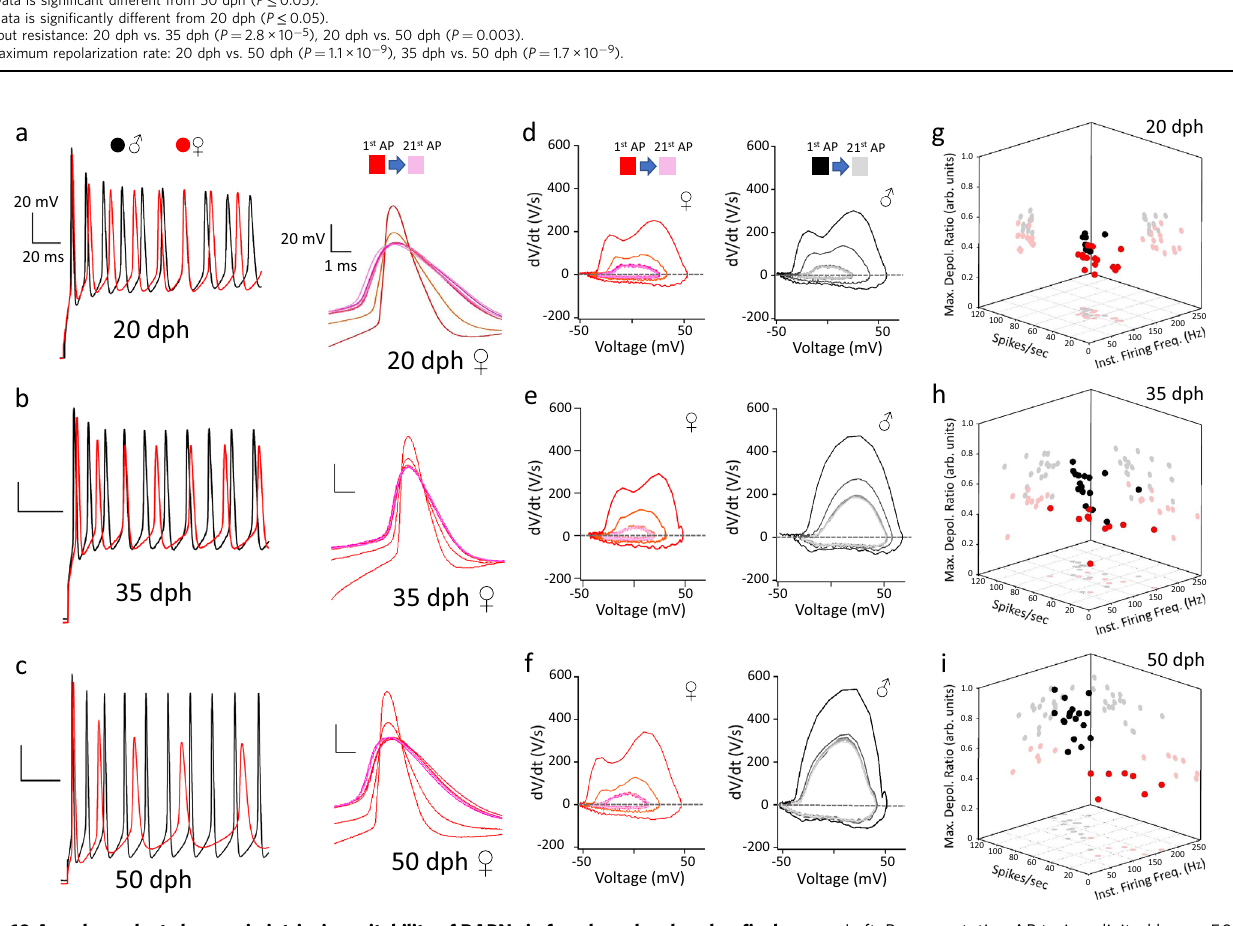
Fig. 10 Age-dependent changes in intrinsic excitability of RAPNs in female and male zebra fi nches. a – c Left: Representative AP trains elicited by a + 500 pA current injection in RAPNs in males (First 10 APs; black; same as in Fig. 6d – f, left) and females (red) across ages (days post hatch, dph). Right: APs #1, 2, and 16 – 21 from the traces on the left aligned at the peaks for each age group in females. d – f Phase plane plots from APs #1, 2, and 16 – 21 plotted at the same scale for all age groups for females (left) and males (right; same as in Fig. 6d – f, right). g – i 3D dot plots showing the instantaneous fi ring frequency (Inst. Firing Freq.), number of spikes per second (Spikes/sec), and the fold-change in maximum depolarization rate (Max. Depol. Ratio; arbitrary units, arb. units) between the 2nd and 1st APs during a 1 s + 500 pA current injection in male (black) and female (red) RAPNs. N (cells/age) = 21/20 dph, 23/35 dph, and 7/50 dph females. Refer to Fig. 6 for male